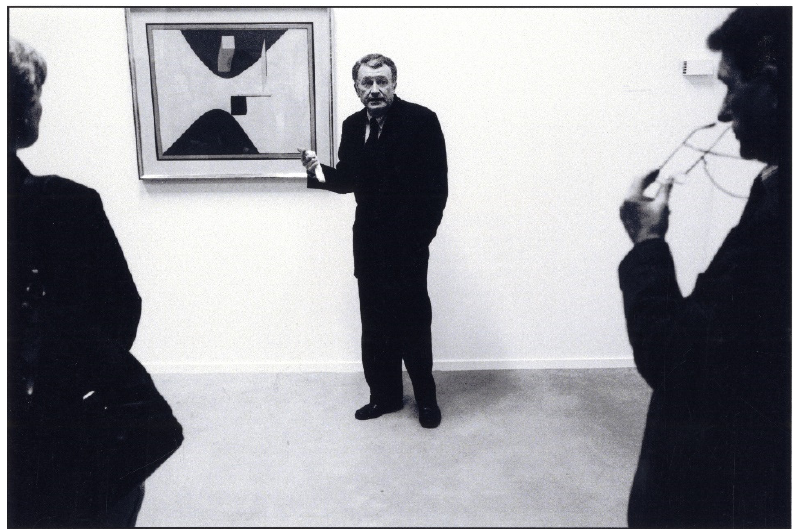
Figure 12. Director Jan Debbaut presents the newly acquired ‘Proun P23, no. 6’, 8 April 1997. Photo from Van Abbemuseum exhibition archive. Photo: Joep Lennarts.